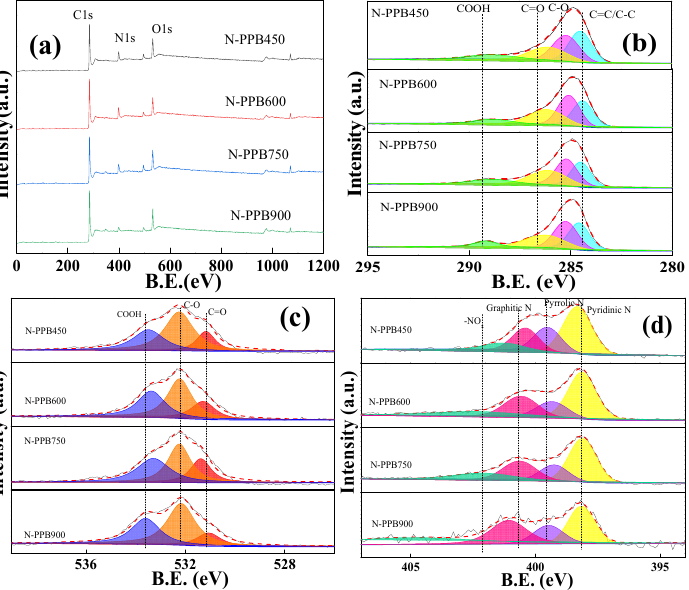
Figure 3. ( a ) Wide-scan XPS spectra, high resolution ( b ) C 1s, ( c ) N 1s, ( d ) O 1s spectra of N-PPB catalysts.